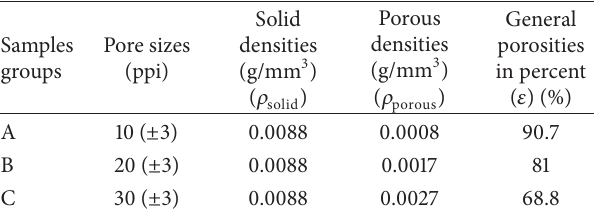
Table 3: General porosities by the pore